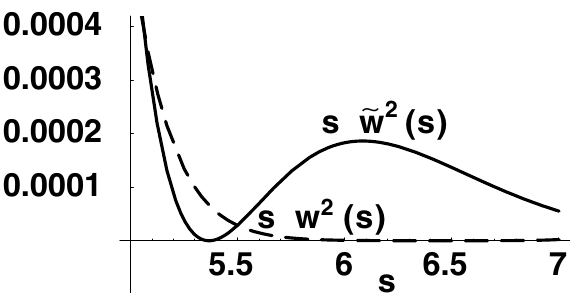
FIG. 11. Blown up picture of Fig. 9 that shows the existence of a node in the position density distribution at s (cid:21) 5 : 4